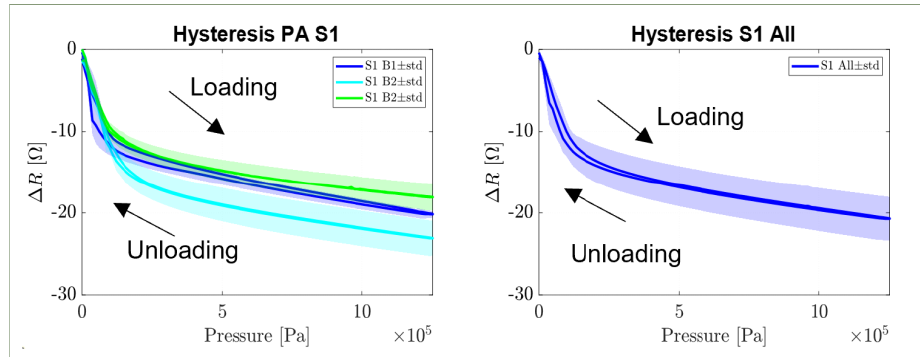
Figure 6. Hysteresis of sensor 1 (board sample (B1, B2, B3) (left) and average behaviour of all boards (right)) as the area comprehended in the resistance curve in the functions of loading and unloading signals.